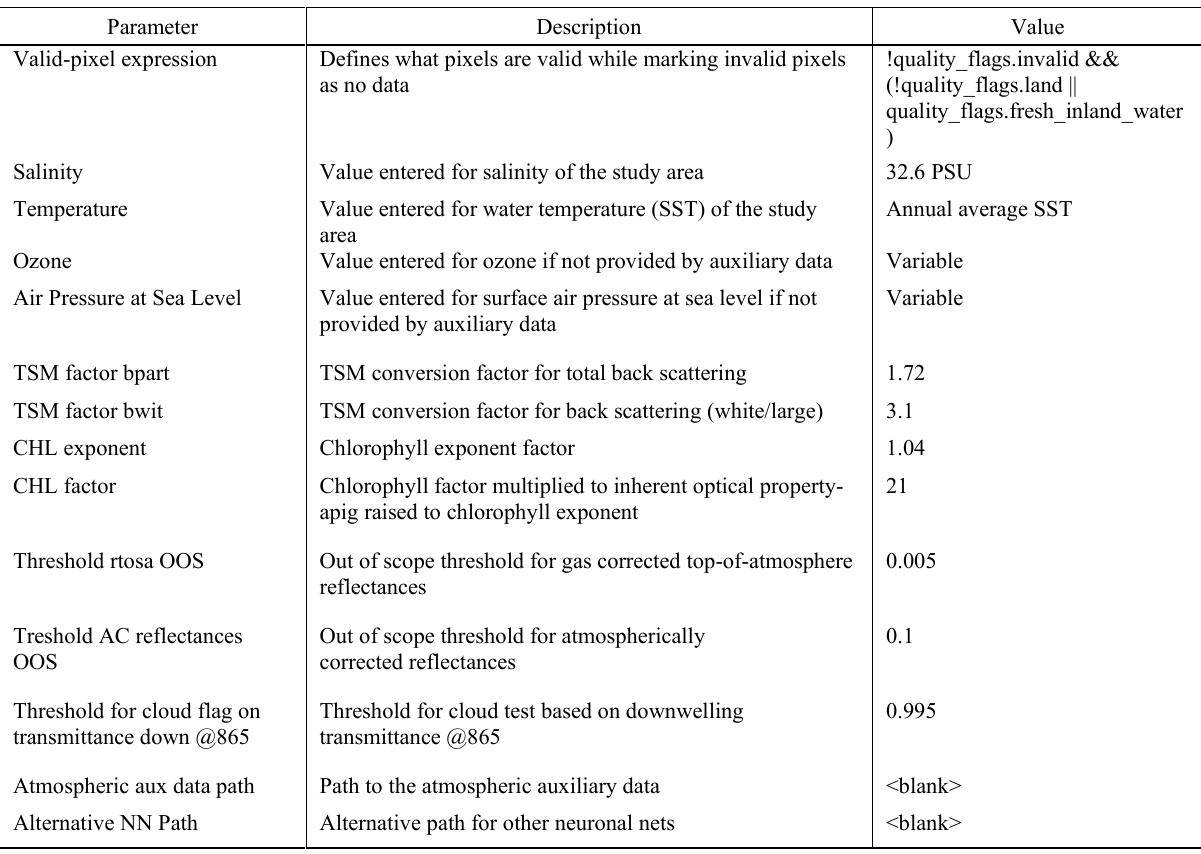
Table 1. C2RCC processing parameters